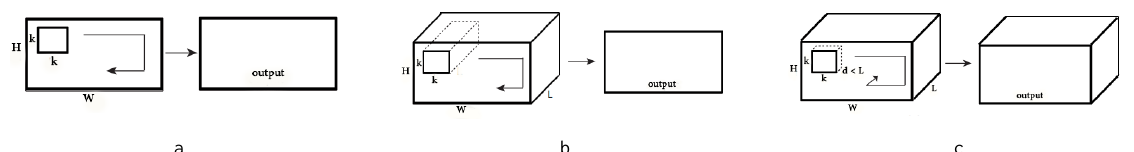
Figure 3. Graphical illustration of the effects of 2D and 3D convolutions on 2D (images) and 3D (videos) input data. a) 2D input and 2D convolution b) 3D input and 2D convolution c) 3D input and 3D convolution [21]. W, H, and L are width, height and length (number of frames) of the input data, respectively. Size of the 2D Convolutional filter is k×k and the 3D filter is of size k×k×d, where d corresponds to the depth of the